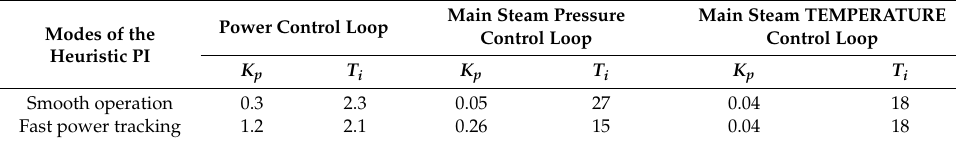
Table 4. Tuning parameters of the heuristic